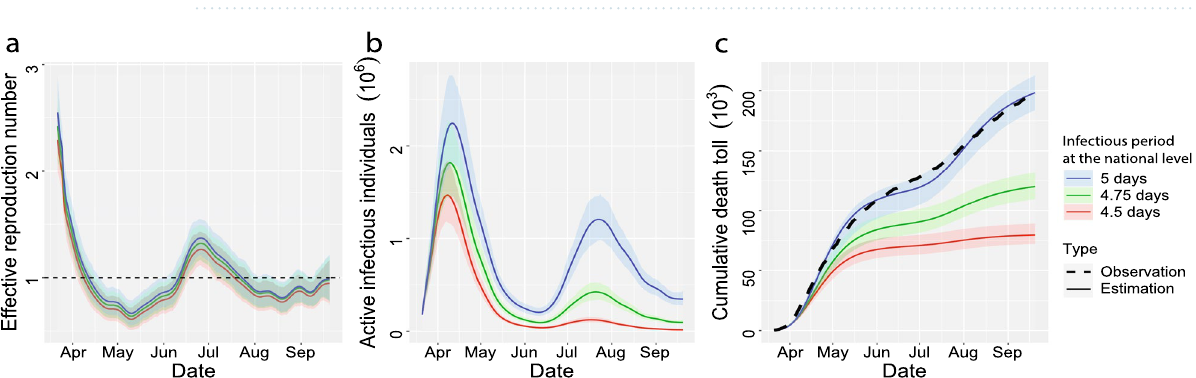
Figure 12. ( a , b ) The estimate reproduction number and overall number of active infective individuals in the US, including 50 states and Washington D.C., from 21 March 2020 to 20 September 2020 with infectious period assumed to be 5 days (blue), 4.75 days (green) and 4.5 days (red). ( c ) The estimate overall death toll in the US. The time period and interpretation of ( c ) are aligned with a and ( b ), except that the black dots in ( c ) stand for the observed death toll in the